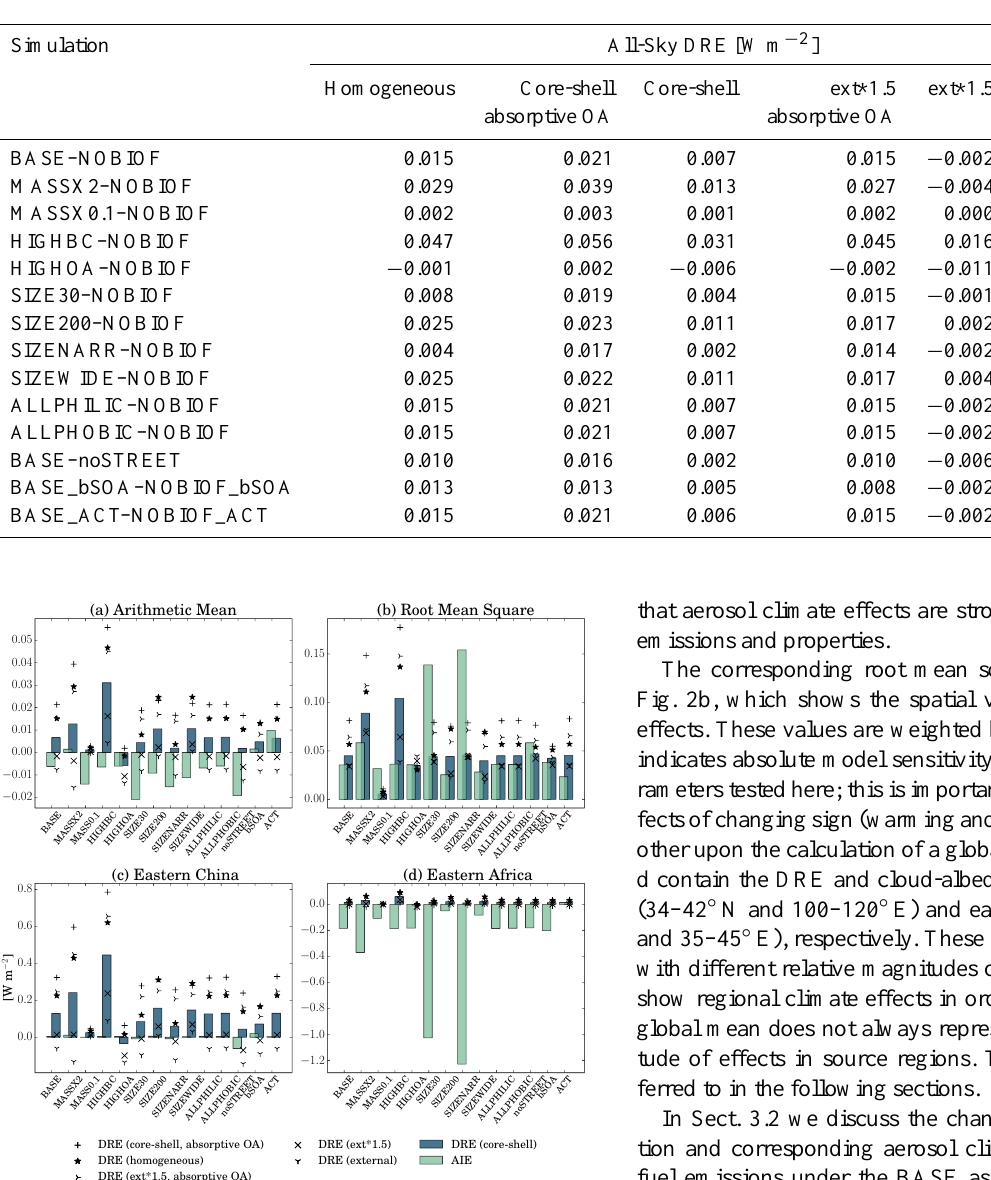
Table 4. The global annual-mean all-sky direct radiative effect (DRE) and cloud-albedo aerosol indirect effect (AIE) due to biofuel for the various comparisons. The direct radiative effect was calculated assuming a homogeneous, core-shell with absorptive OA, core-shell, ext*1.5 with absorptive OA, ext*1.5, and external mixing state (see Table 1).